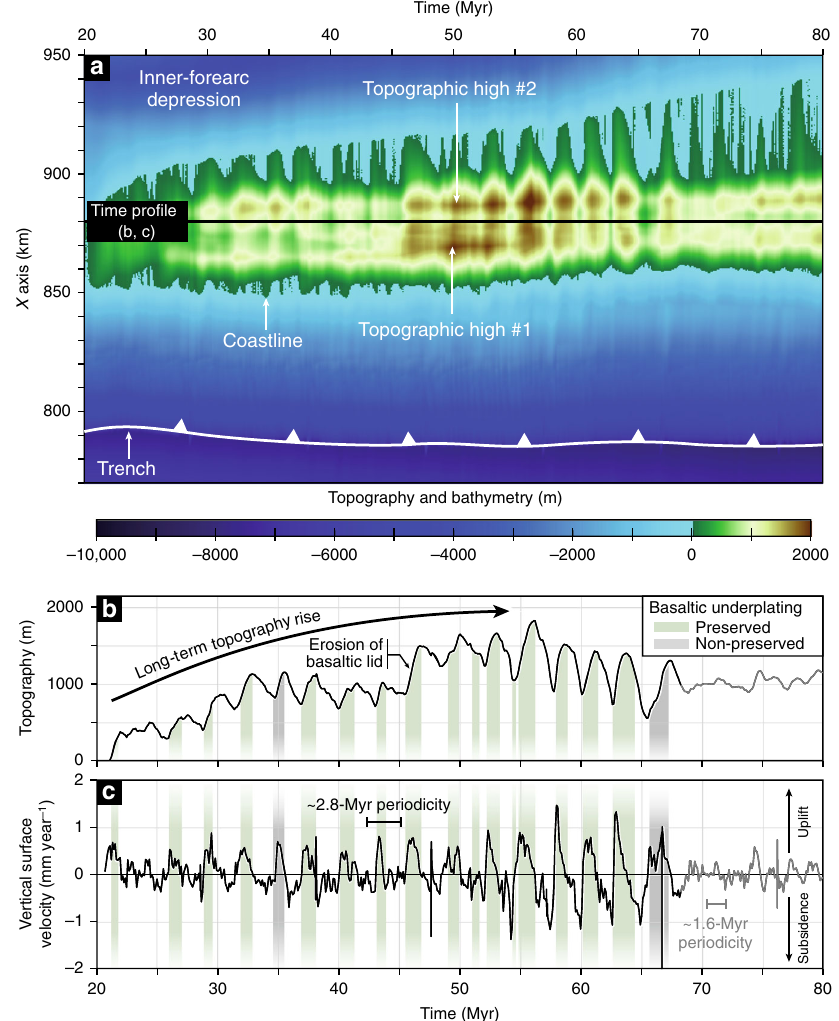
Fig. 3 Periodic evolution of forearc topography through time. a Dynamics of the forearc topography showing the periodic evolution of the coastal topography with alternating uplift and subsidence events and a horizontal migration of the coastline. b , c Time pro fi les showing the topography ( b ) and vertical surface velocity ( c ) variations of the coastal topography from 20 to 80 Myr (see a for the exact location of the pro fi le). Green (or grey) bands denote the timing of tectonic underplating of basaltic slices, which are preserved (or not) in the duplex structure. Note that each basaltic underplating event is correlated with an uplift pulse. Partial erosion of the early accreted, thick basaltic lid on top of the duplex (Fig. 2) has a limited effect on predicted topographic evolution with a slightly more pronounced uplift of ~600 m at ~46 Myr. Finally, the sudden change from sediment-and-basalt to only-sediment underplating after ~68 Myr results in a drastically different topographic signal characterized by lower amplitude and periodicity (compare black and grey